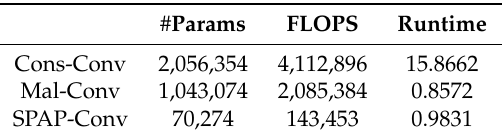
Table 3. Experimental results about efficiency, where #Params indicates the number of trainable parameters, FLOPS stands for floating-point operations per second, and Runtime is the time spent for running the model on the test set in